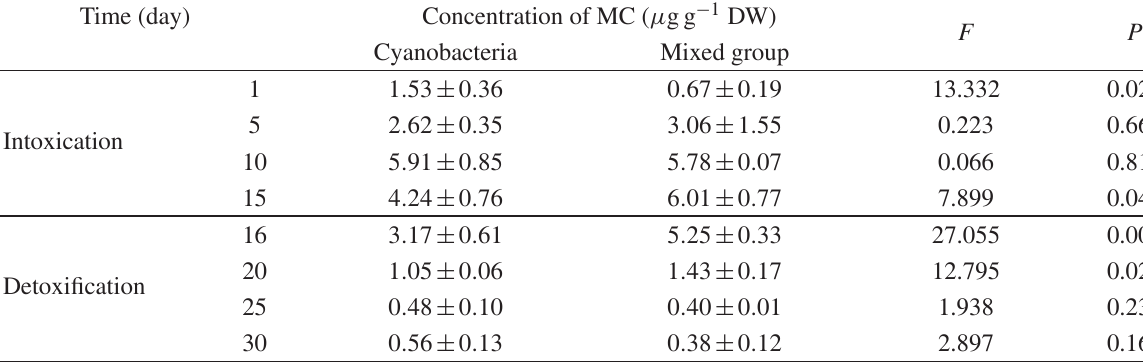
TABLE 1: MCs concentration in hepatopancreas of snails ( B. aeruginosa ) exposed to different treatments during the experiment. Results are expressed as mean ±